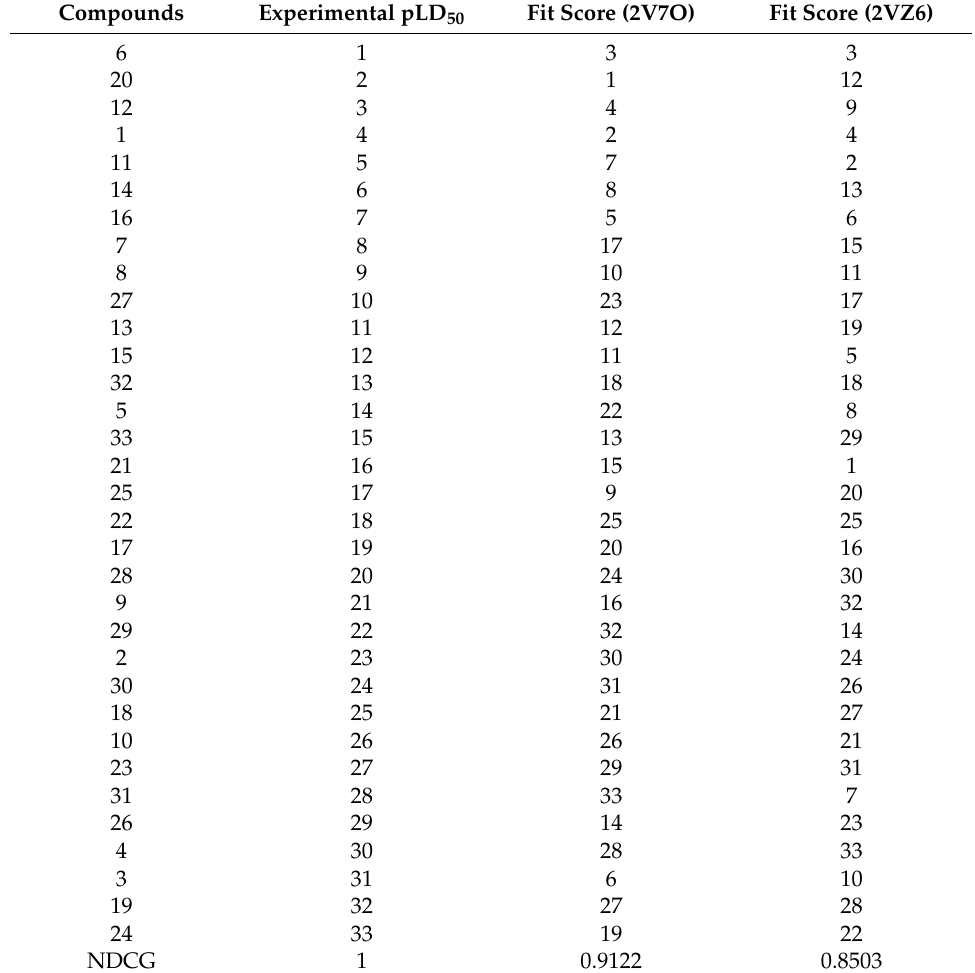
Table 3. Ranking results by experimental and predicted pLD 50 and fit